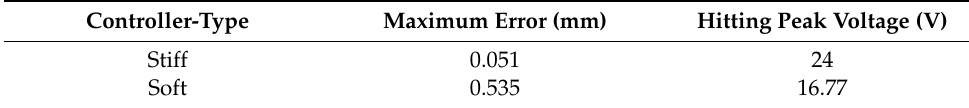
Table 3. Observable performance of the proposed controller.